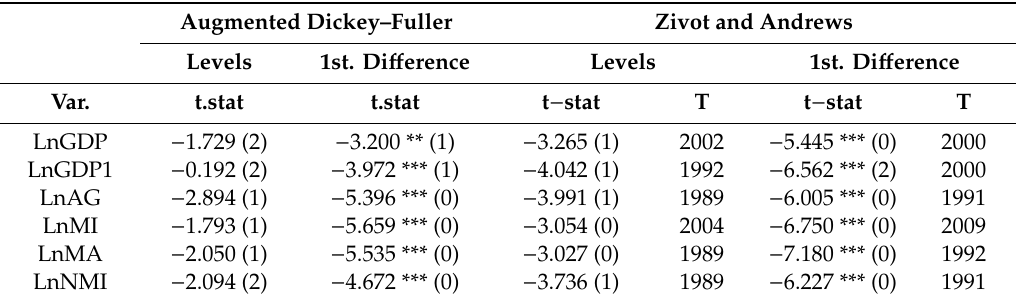
Table 5. Autoregressive Distributed Lag (ARDL) bounds test for co − integration (case 3) results.